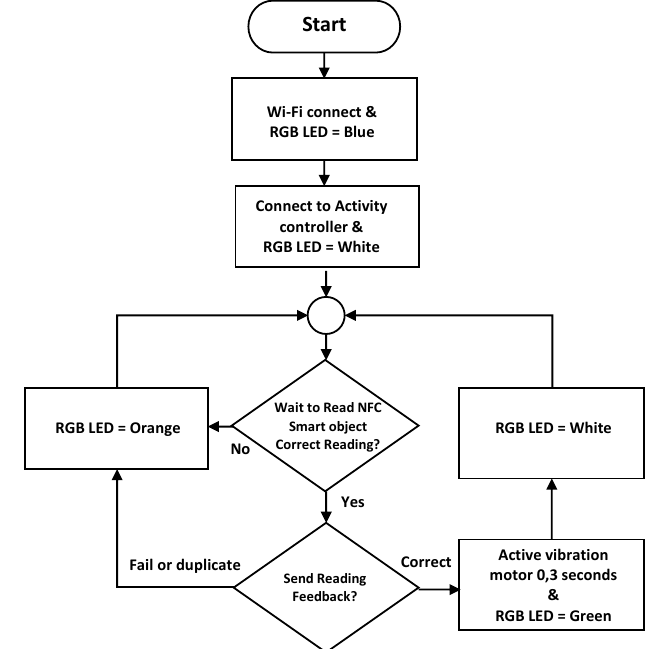
Figure 11. MovED operation flowchart.